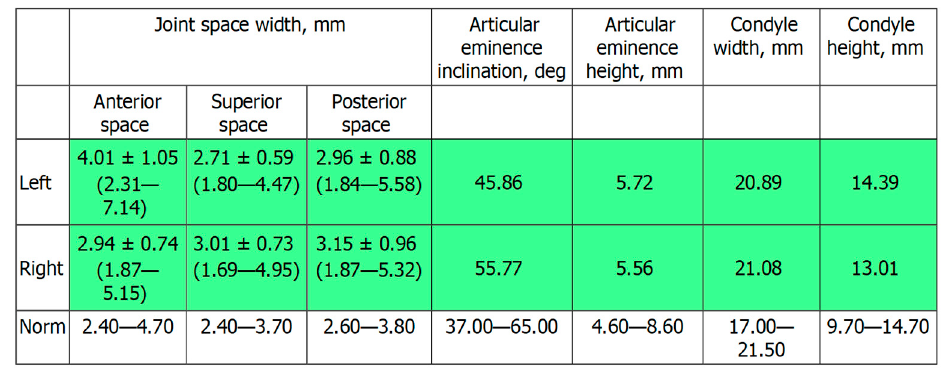
Figure 13. Table showed by the software. TMJ analysis after dental treatment, with normal intra- articular space widths both in the left and right TMJ.